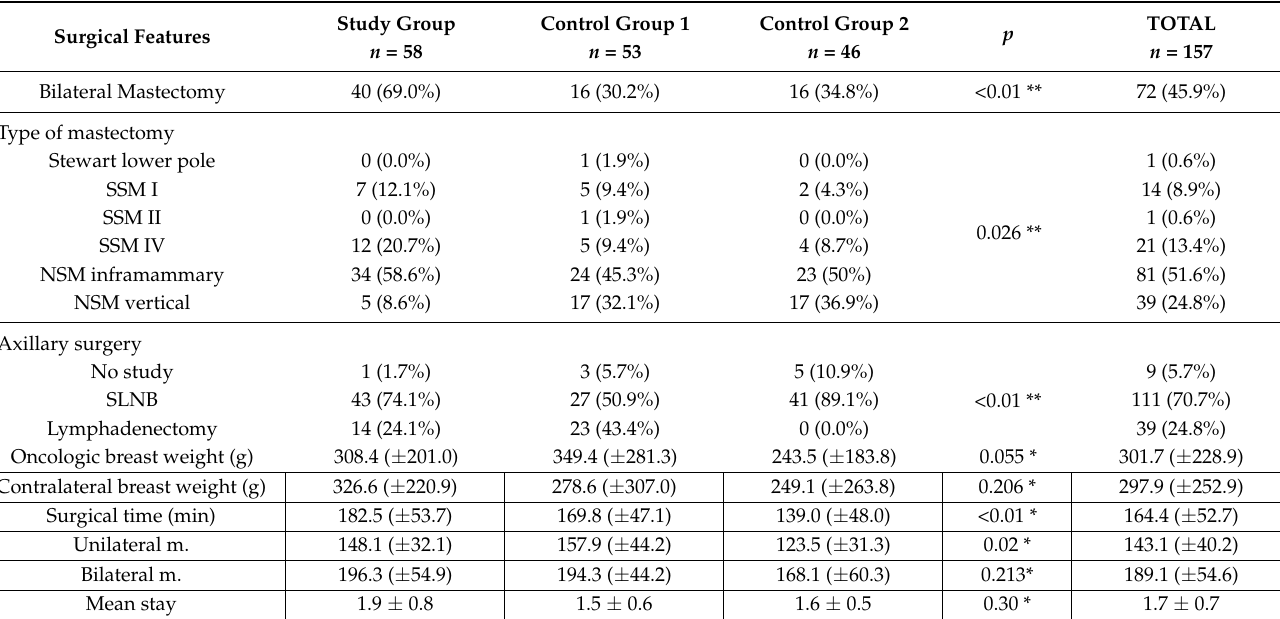
Table 2. Patients’ surgical